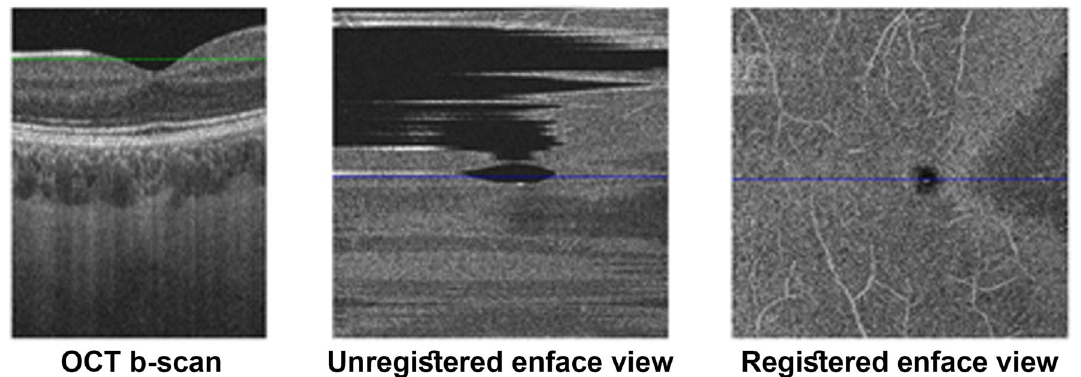
Figure 5. Example of volume registration. The left image shows the front view of a b-scan OCT foveal slice (z = 166) corresponding to the blue line in enface views. The central image represents the original enface view of a plane (y = 84) corresponding to the plane cut by the green line in b-scan OCT. Right image shows the same enface view after volume registration.